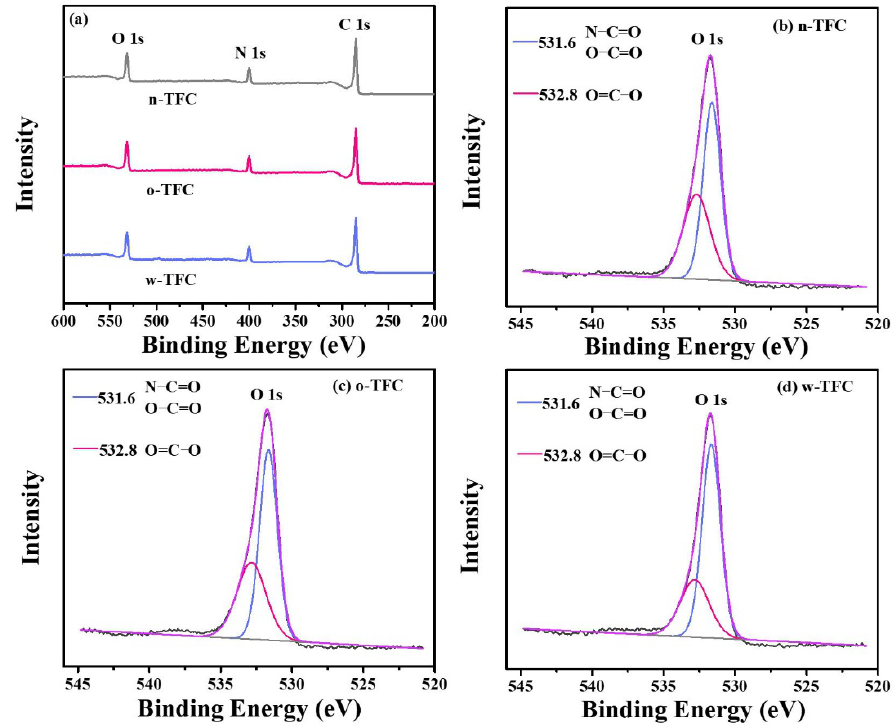
Figure 6. ( a ) The ray photoelectron spectroscopy ( XPS) wide-scan spectra of TFC membranes